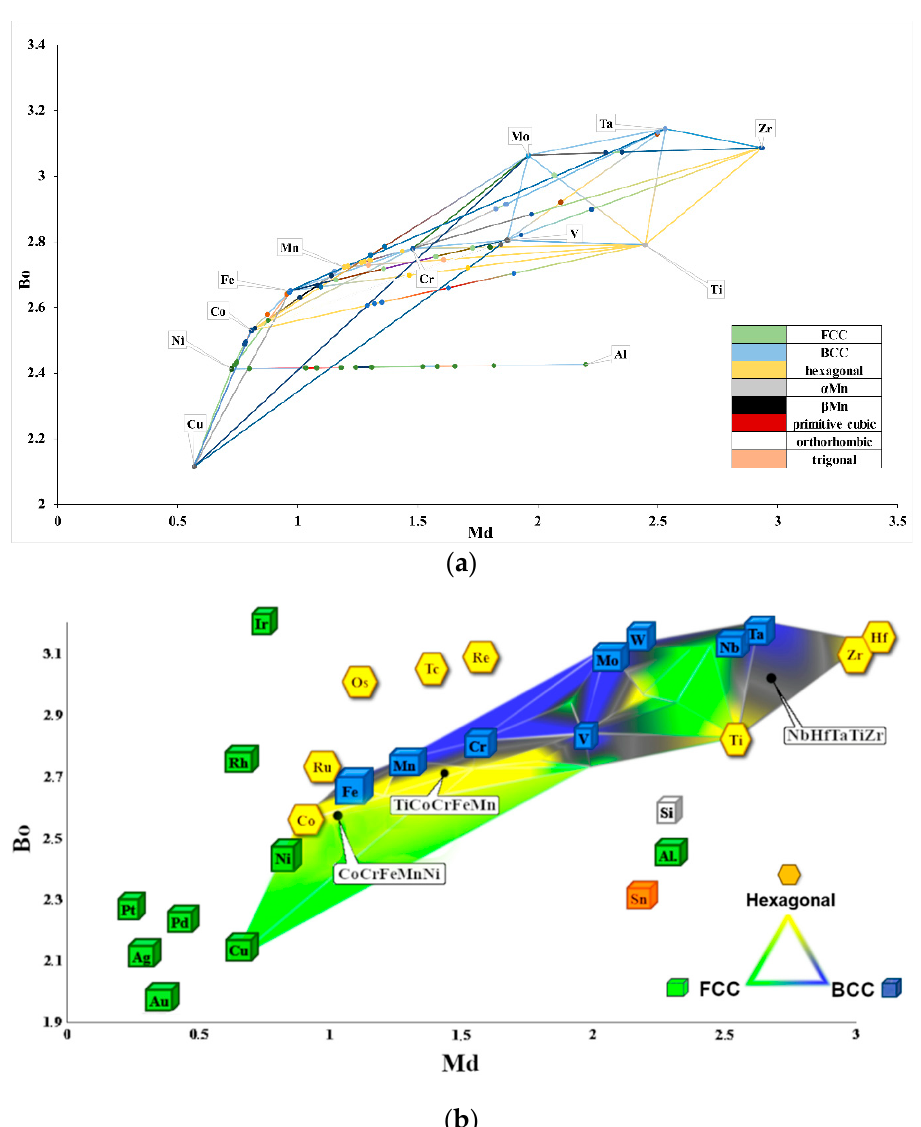
Figure 3. The Bo–Md diagram developed using the molecular orbitals method for elements based on the FCC, BCC and hexagonal lattices together with the position of the designed TiCoCrFeMn alloy in the BCC + hexagonal two-phase area, the Cantor CoCrFeMnNi alloy with the FCC lattice and the NbHfTaTiZr alloy with the BCC lattice [3]; construction lines compatible with double equilibrium systems ( a ) and the area of dominant phases with BCC, FCC and hexagonal structure ( b ).